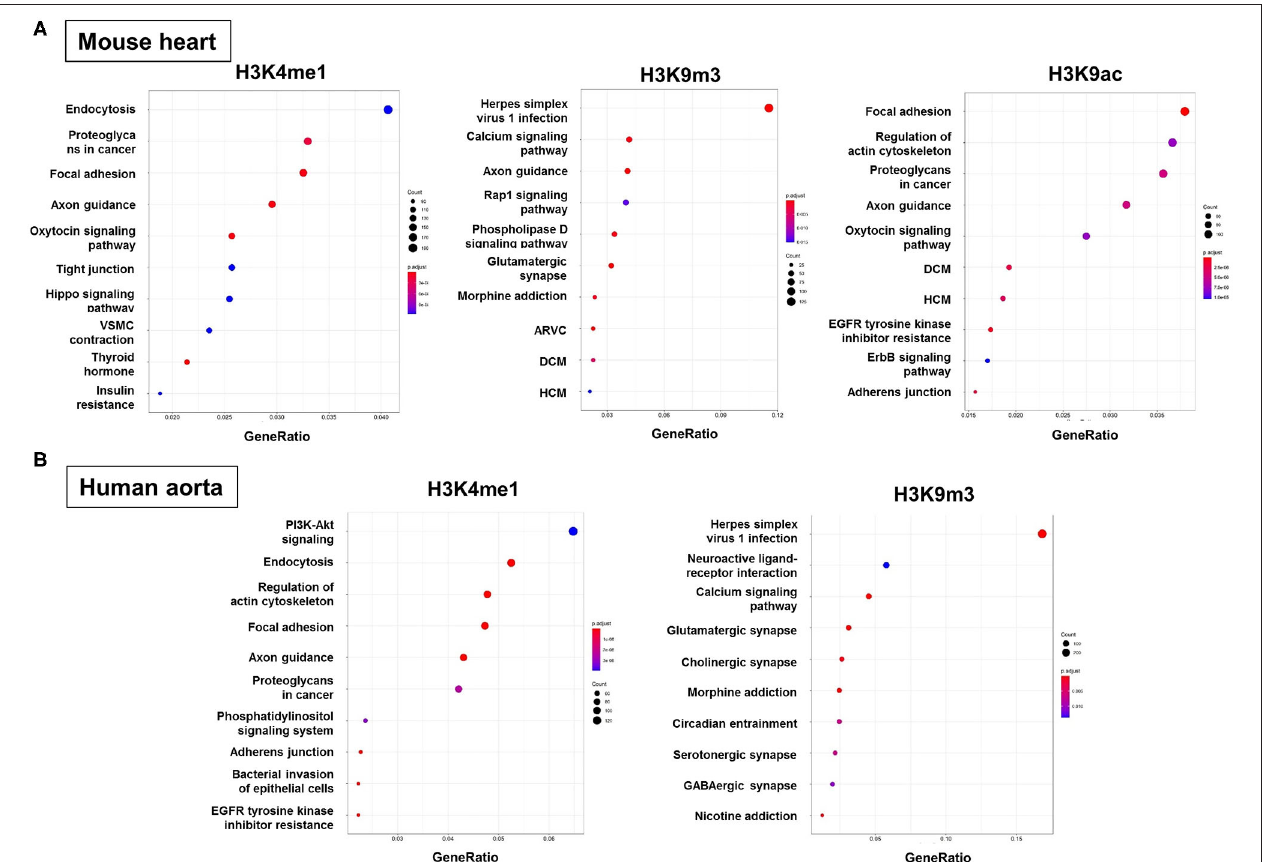
FIGURE 6 | Functional enrichment analysis of genes with H3 modifications. GO terms, KEGG pathways and Reactome pathways databases were used as an input for functional enrichment analysis. Pathways and GO terms that are enriched for genes with H3K4me1, H3K9m3, and H3K9ac in mouse heart tissue (A) and genes with H3K4me1 and H3K9m3 in human aorta tissue (B) . The results of GO terms and Reactome pathways are shown in Supplemental Materials . GO, gene ontology; KEGG, kyoto encyclopedia of genes and genomes; ARVC, arrhythmogenic right ventricular cardiomyopathy; DCM, dilated cardiomyopathy; HCM, hypertrophic